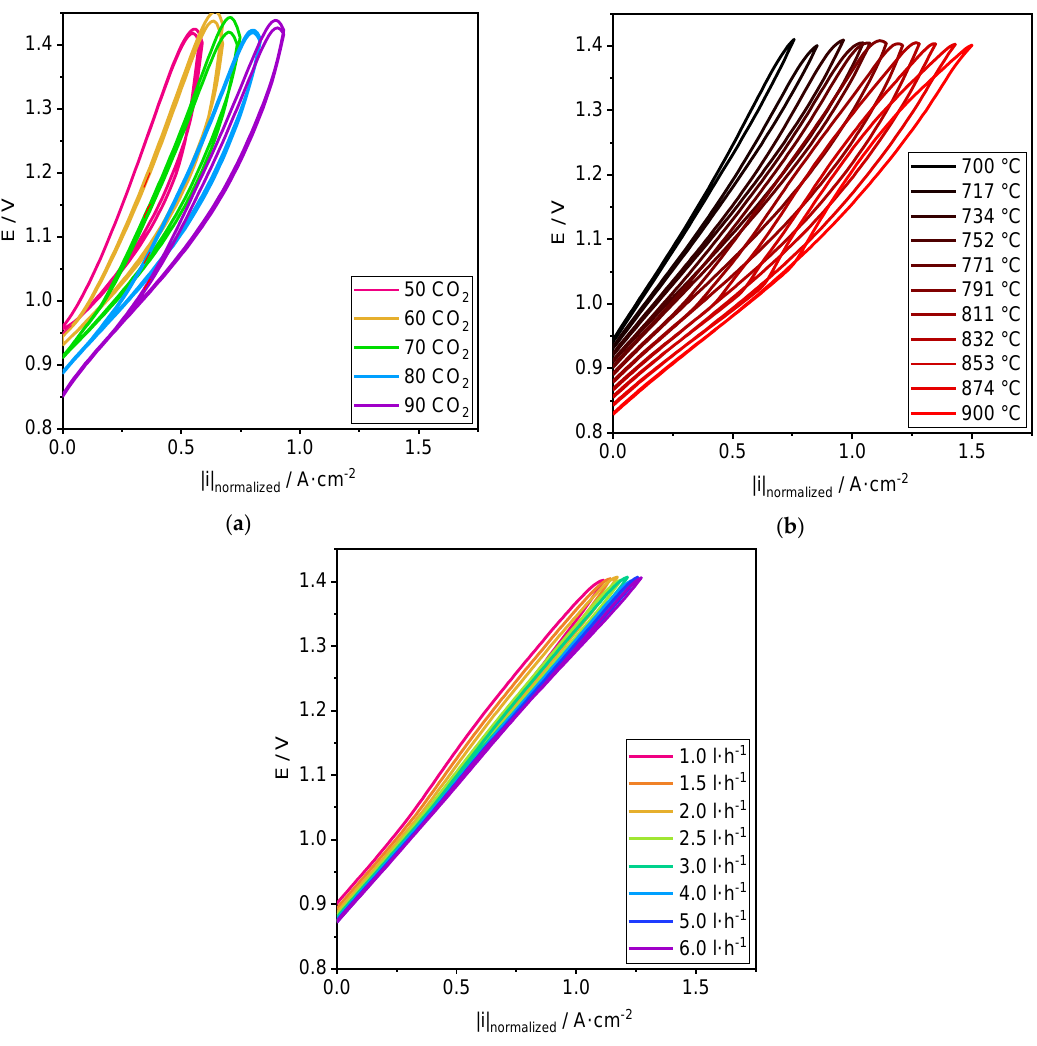
Figure 1. iV curves at various operating parameters: ( a ) variation of CO 2 :CO ratio at 800 °C and 6 l·h -1 ; ( b ) variation of temperature for a ratio of CO 2 :CO of 80:20 at 6 l·h −1 ; ( c ) variation of flow rate for a ratio of CO 2 :CO of 80:20 at 800 °C.